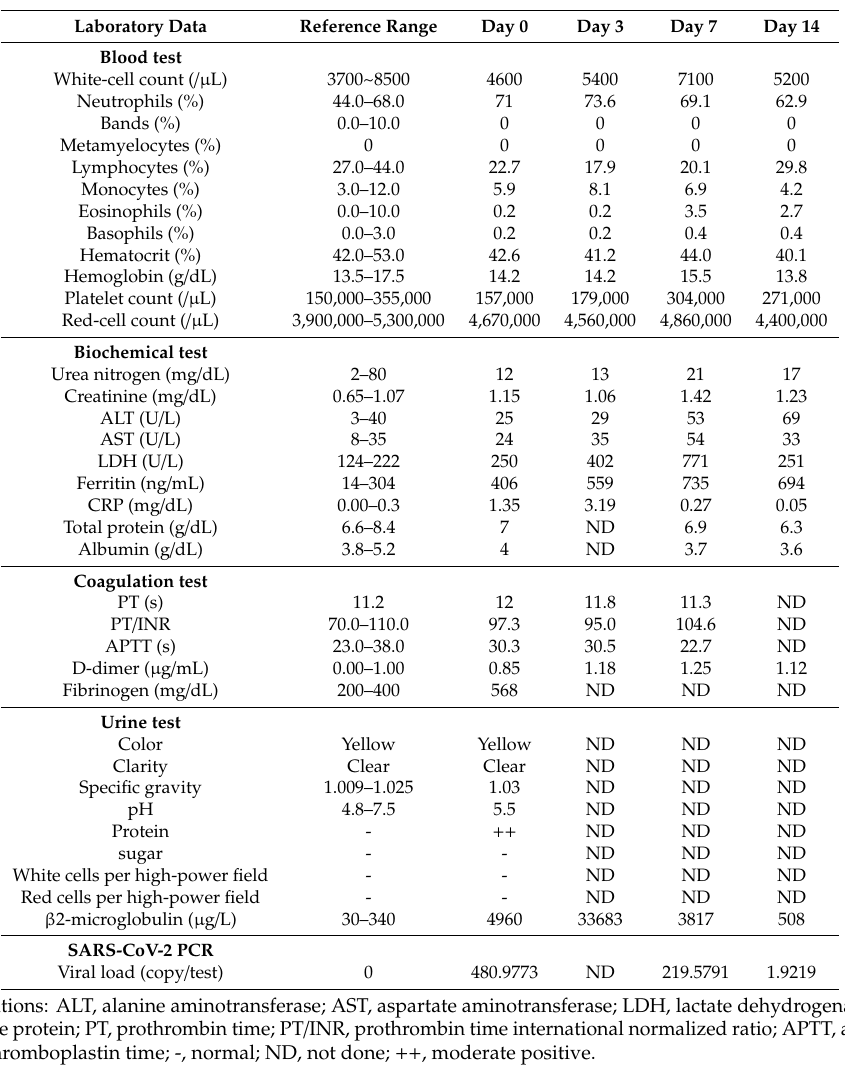
Figure 2. Fluctuations of the patient’s oxygen saturation (SpO 2 ), body temperature, and SpO 2 /FIO 2 ratio during his hospitalization. The drug dosing period is shown at the top of the figure. Because we suspected that this patient had CRS, we administered TCZ (400 mg) intravenously with a histamine H1-receptor blocker on day 3. One day later (day 4), he became afebrile, and his other clinical symptoms, such as shortness of breath, cough, sputum, and general fatigue, were ameliorated within a few days. Four days after the TCZ injection (day 7), the patient’s levels of CRP and urine B2M decreased , and his platelet count increased. Notably, the patient’s levels of LDH, ferritin, and D-dimer all temporarily increased at 4 days after TCZ administration (day 7), followed by declines. Because the patient’s condition had improved, the nafamostat was discontinued on day 7, and the ciclesonide and favipiravir were discontinued on day 11 (Figure 2). On day 11, the patient’s SpO 2 in ambient air increased to 95%. Eleven days after the TCZ injection (day 14), the patient’s laboratory findings improved (Table 1). A chest CT scan at that time revealed that the GGOs had reduced in size and that the lesions had changed into a small consolidation or developed a cord-like appearance (Figure 1c). The viral load of SARS-CoV-2 as measured by PCR also decreased (Table 1).